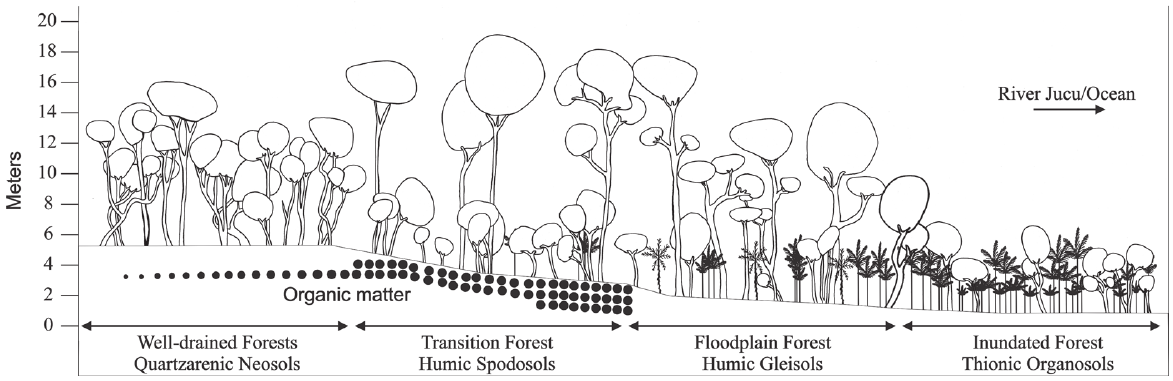
Figure 2 - Schematic profile perpendicular to the River Jucu in Jacarenema Natural Municipal Park, Vila Velha,